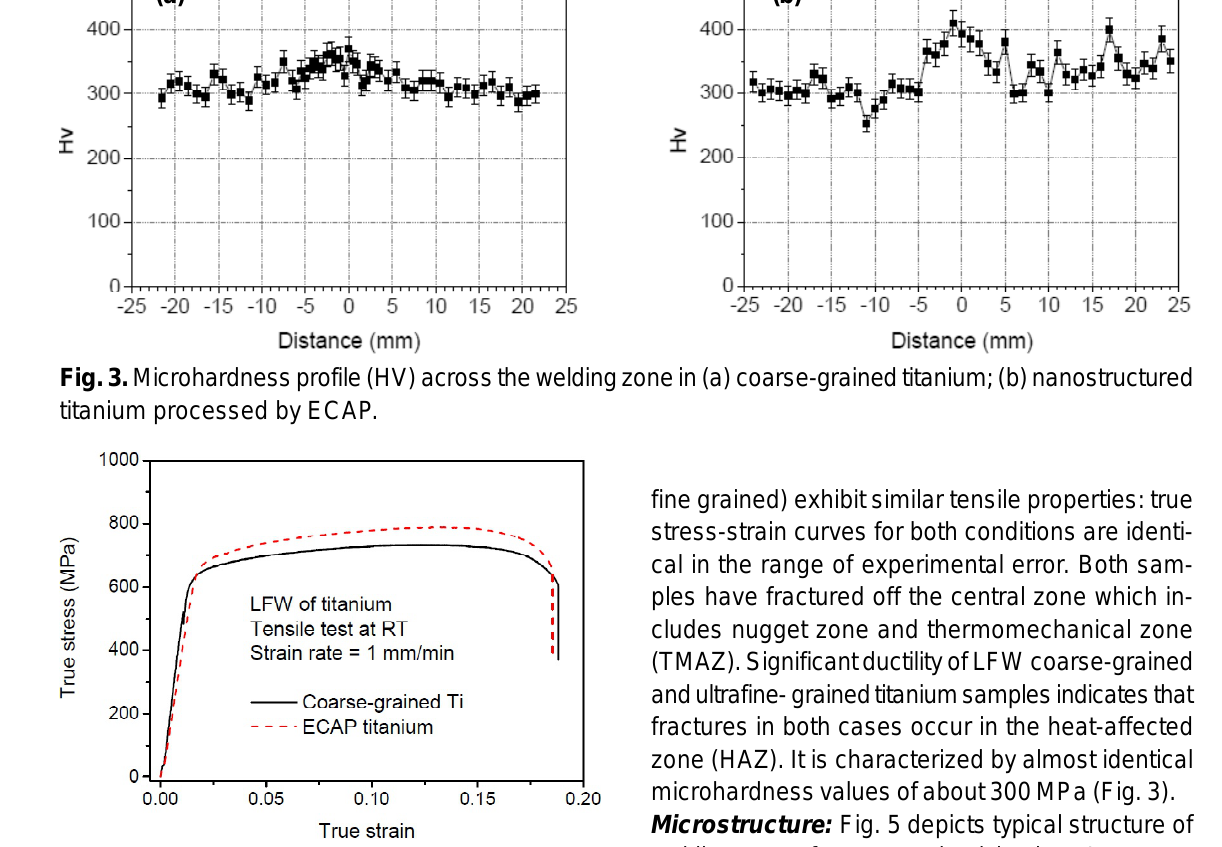
Fig. 4. True stress-strain curves of titanium LFW samples tested in tension mode.